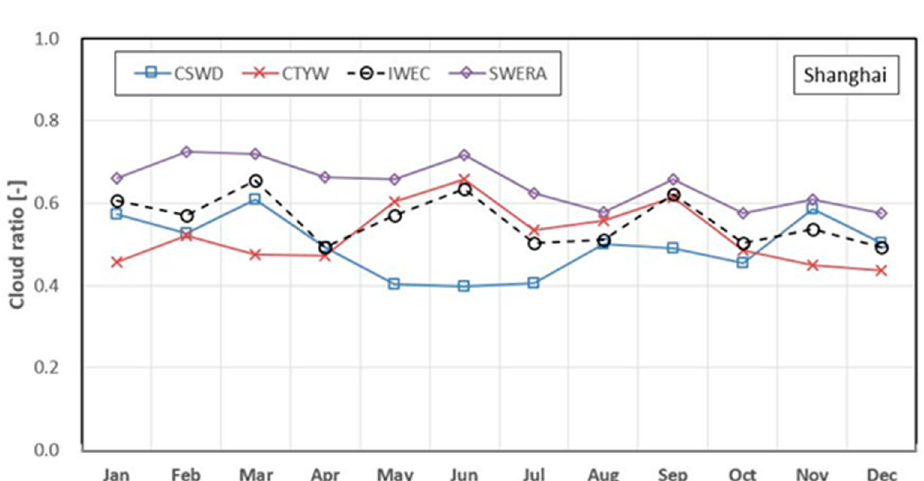
Figure 1. Calculated monthly cloud ratios among four kinds of TMY database in Shanghai, China.